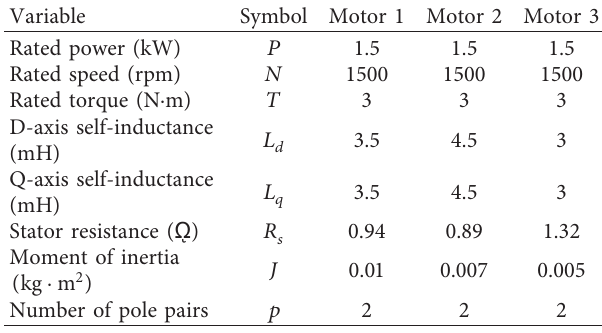
Table 1: Three-motor mechanical parameters.